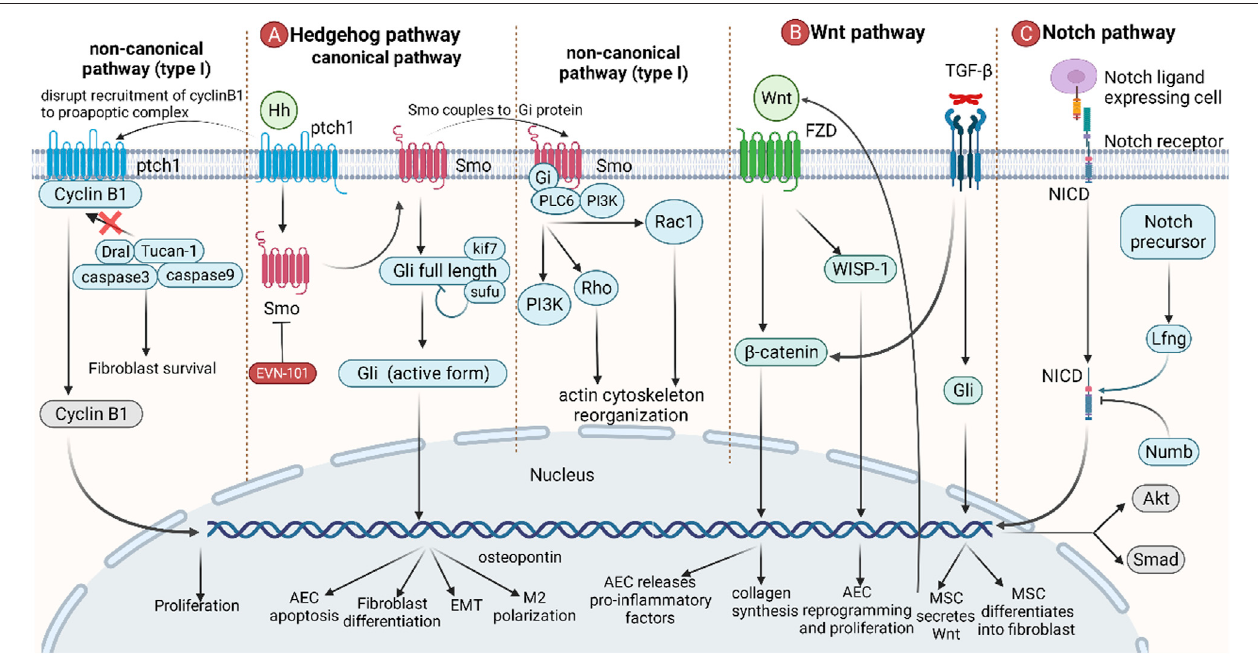
FIGURE 5 | The role of developmental pathways in IPF. (A) Canonical hedgehog pathways start from the binding of Hh to ptch1, and Smo then migrates to the plasmamembrane,releasingandactivatingfull-lengthGli,whichleadstoAECapoptosis, fi broblastdifferentiation,EMT,andM2polarization.Innon-canonicalhedgehog pathways(typeI),bindingofHhtoptch1blocks therecruitmentofthepro-apoptotic complexbycyclinB1,resultinginanti-apoptosisandpromotionofcellproliferation. In non-canonical hedgehog pathways (type II), Smo is coupled to Gi protein, activating downstream PI3K, Rho, and Rac1, resulting in an increase in intracellular calciumconcentration andarearrangement ofthecytoskeleton. (B) Wntpromotestheaccumulationof β -cateninbybindingtoFZD,therebystimulatingAECstorelease proin fl ammatory factors and promote collagen synthesis in fi broblasts. Wnt also directly induces AEC reprogramming and proliferation via WISP-1. TGF- β can induce MSCs to secrete Wnt and promote MSC differentiation. (C) The Notch ligand binds to the Notch receptor, causing the Notch intracellular domain (NICD) of the Notch receptor to break and enter the nucleus, leading to gene transcription. Lfng positively regulates this process, while Numb negatively regulates this process. Wnt is also involved in the regulation of Akt and Smad